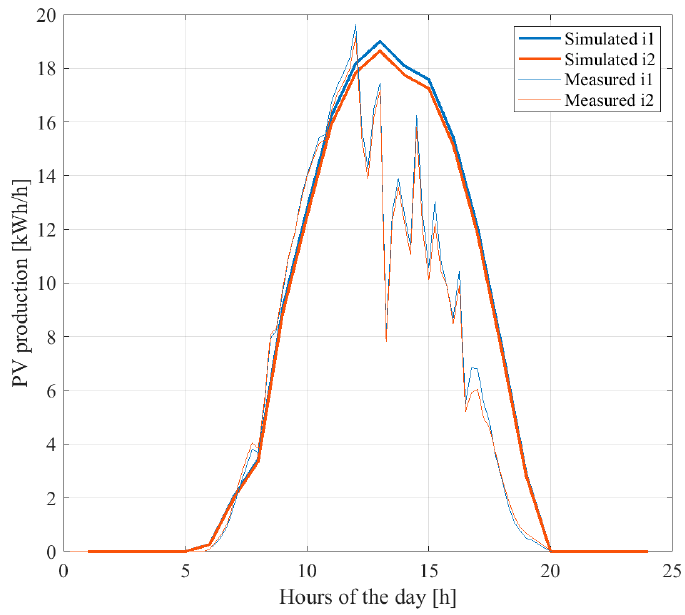
Figure 6. PV production available on 30 August 2021. Comparison between the simulated data and measured data after the inverters, for both the bifacial panels (i1) and the mono-facial panels (i2).